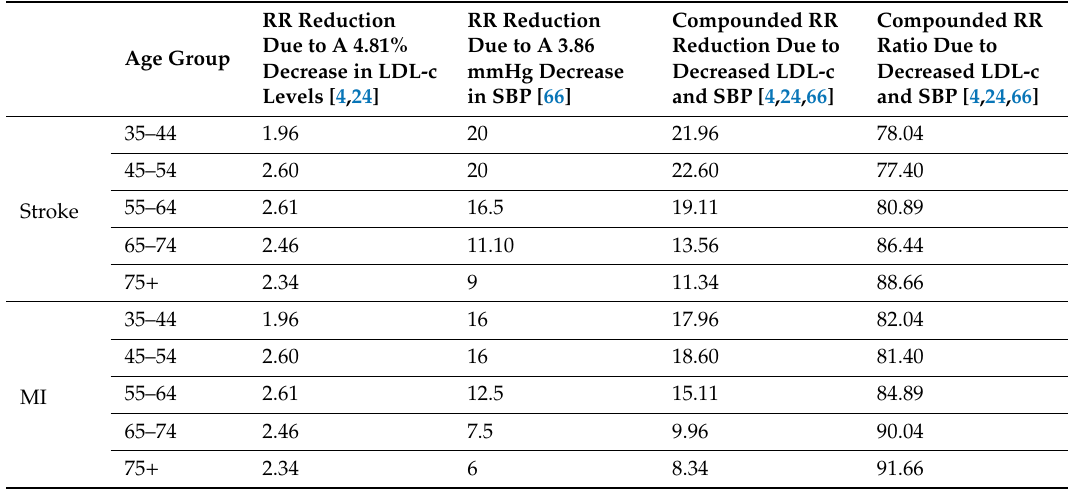
Table 2. E ff ectiveness of potassium and phytosterols to reduce the CVD